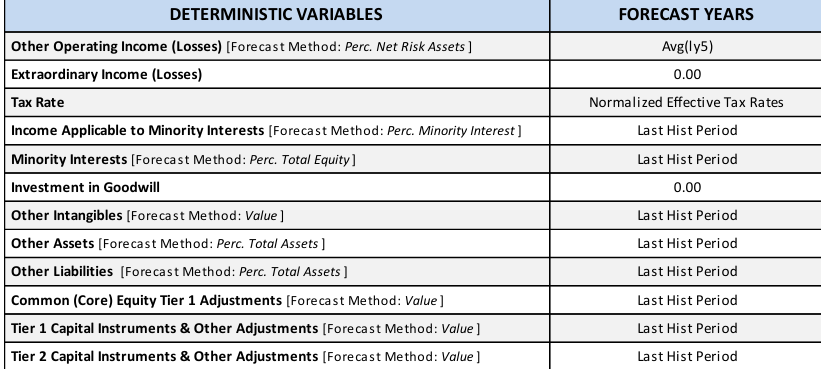
Figure A3. Correlations assumptions. Data Source and Processing: Bloomberg: historical financial statement data, consensus forecast on GDP. B anks’ financial statement report (Pillar 3 section): regulatory requirement data set. Data elaboration and stochastic simulations have been processed by value.Bank , software application available on Bloomberg terminal (APPS VBANK <GO>). 55 See Cohen (1988).